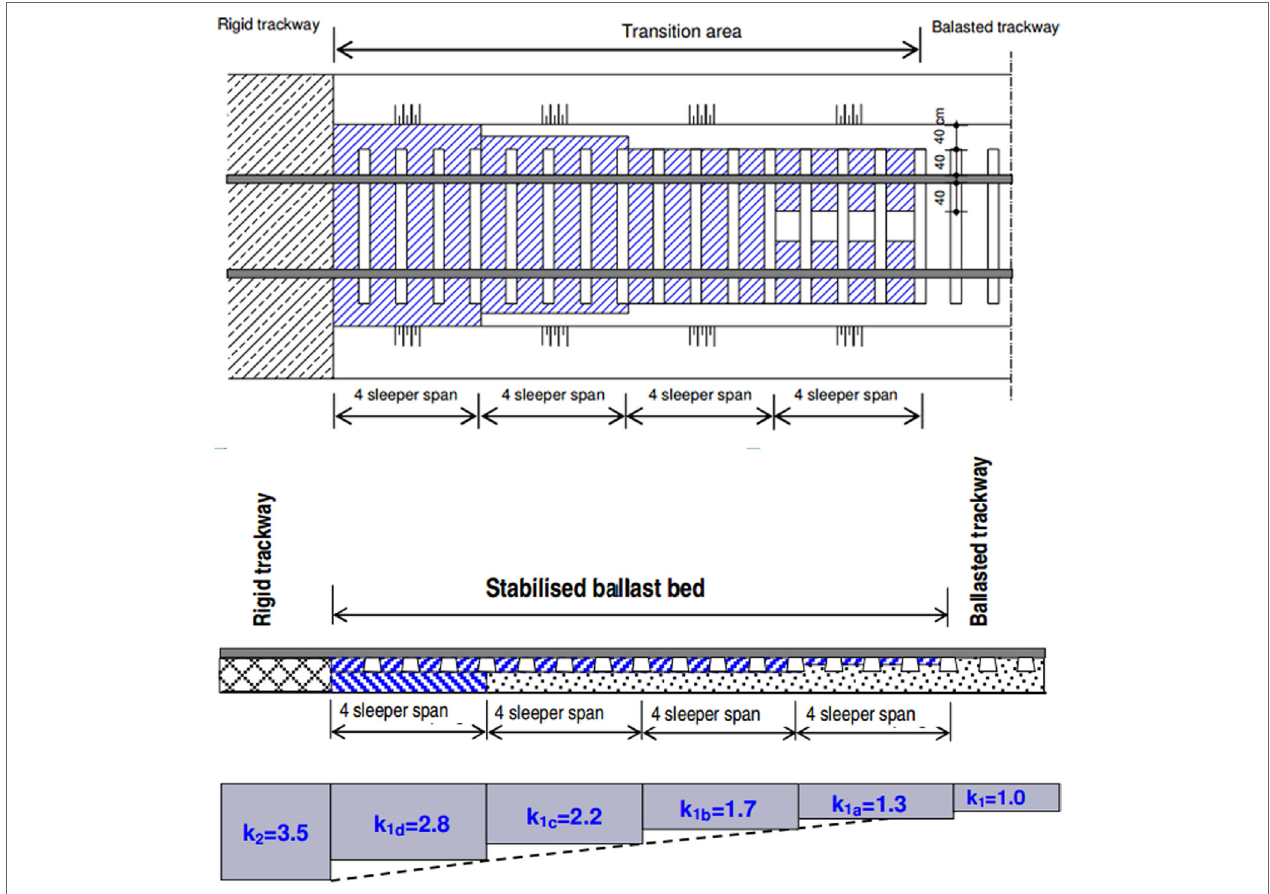
Figure 2 | Gradual change in track stiffness on transition area (Lakušic et al.,